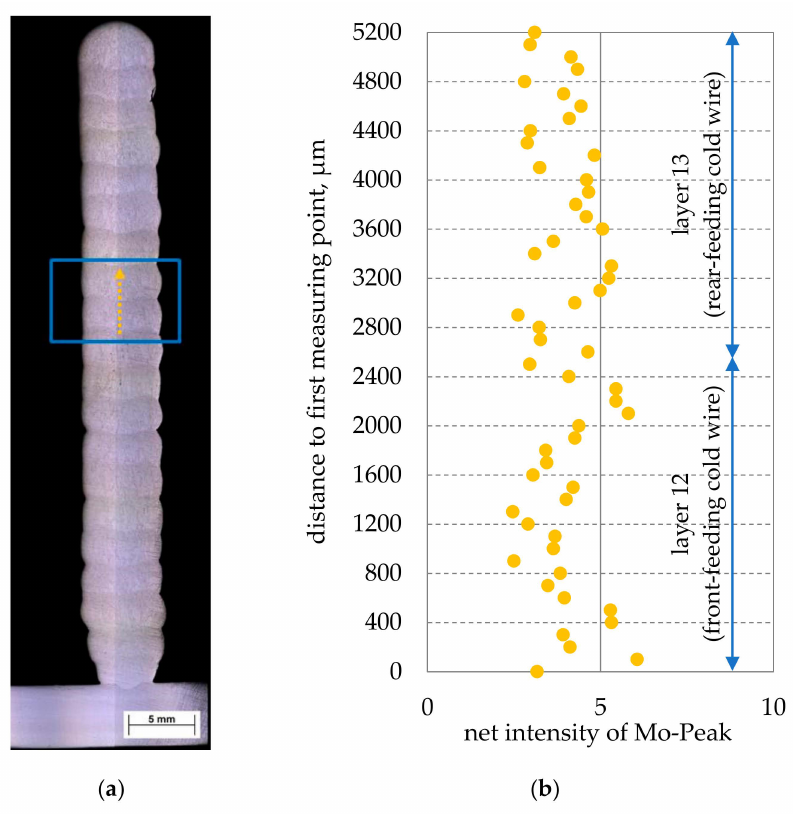
Figure 5. Molybdenum net intensity as a function of the position in the specimen, ( a ) macrosection indicating the location of the EDS line scan, ( b ) net intensities of the molybdenum peaks in layer 12 (front-feeding cold wire) and layer 13 (rear-feeding cold